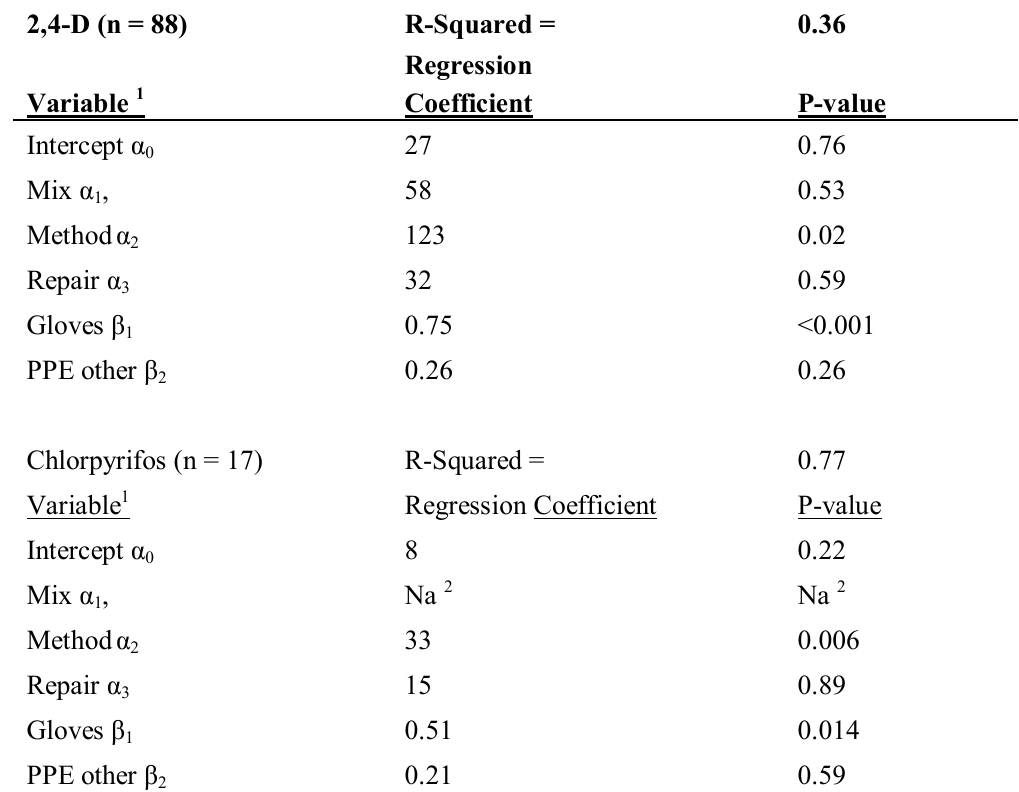
Table 4. Nonlinear regression of post-application urine concentration on